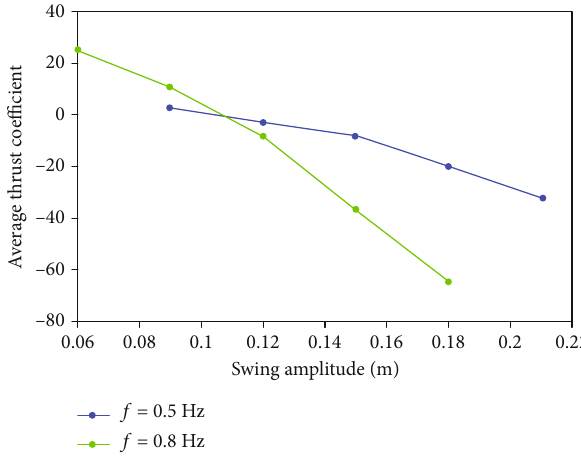
Figure 10: Comparison of average thrust coe ffi cient in di ff erent swing